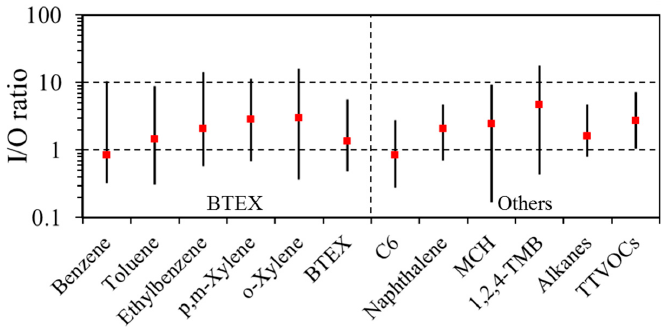
Figure 2. Indoor/outdoor (I/O) concentration ratios at 10th, 50th (red square) and 90th percentiles.